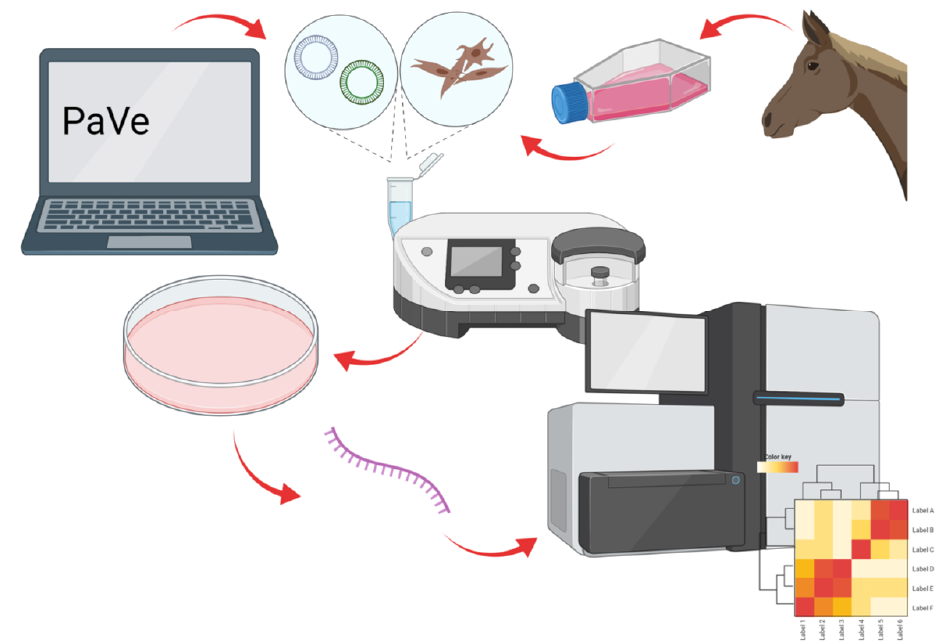
Figure 7. Experimental schedule. Created with BioRender.com [64].